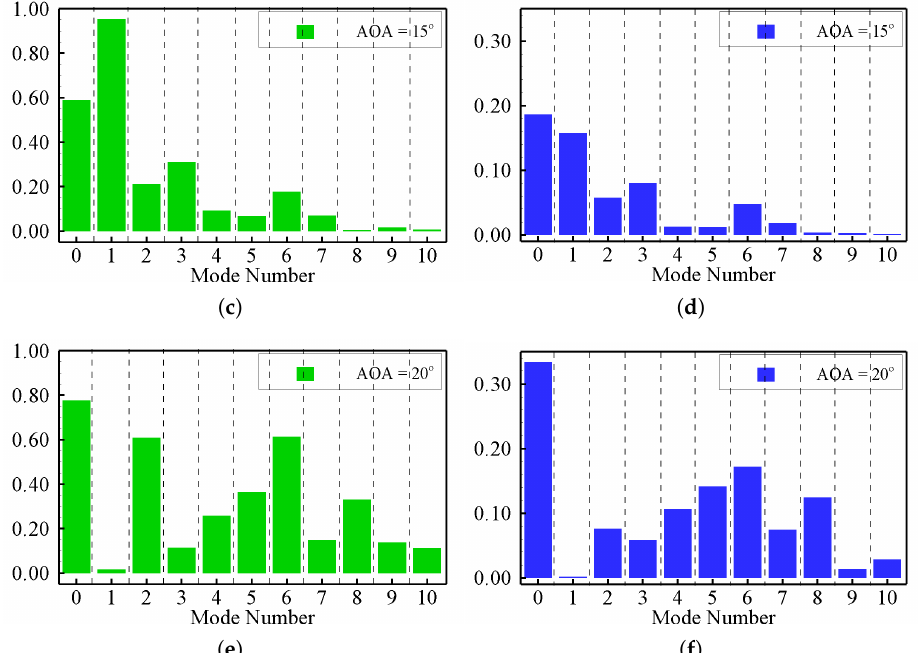
Figure 13. ( a , c , e ) Magnitude of mean and the first ten LDC, ( b , d , f ) Magnitude of mean and the first ten DDC: AOA = 10 ◦ , 15 ◦ , and 20 ◦ , top to bottom.